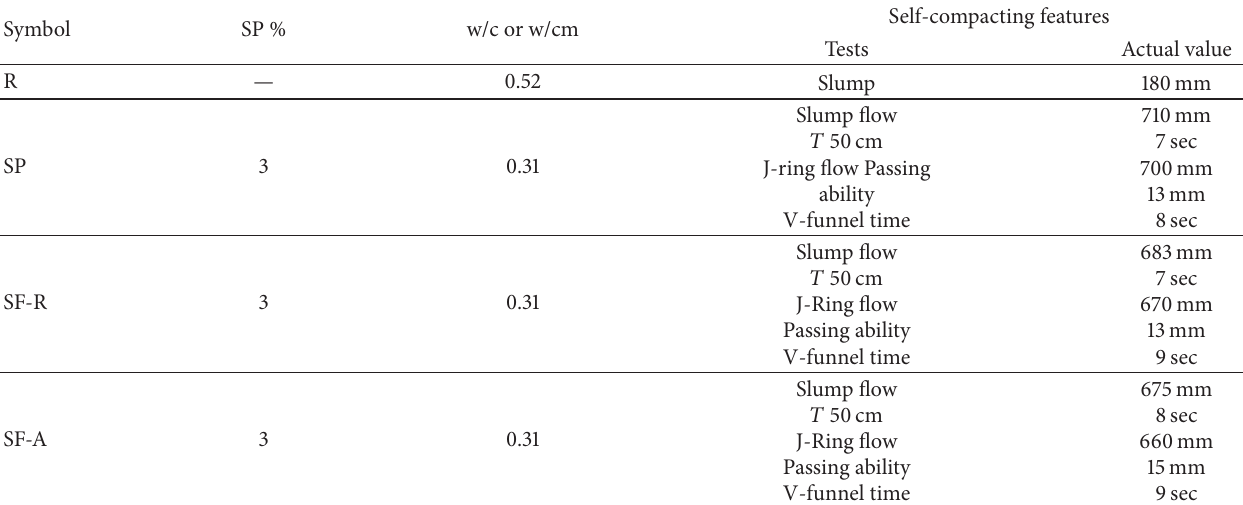
Table 3: Self-compacting